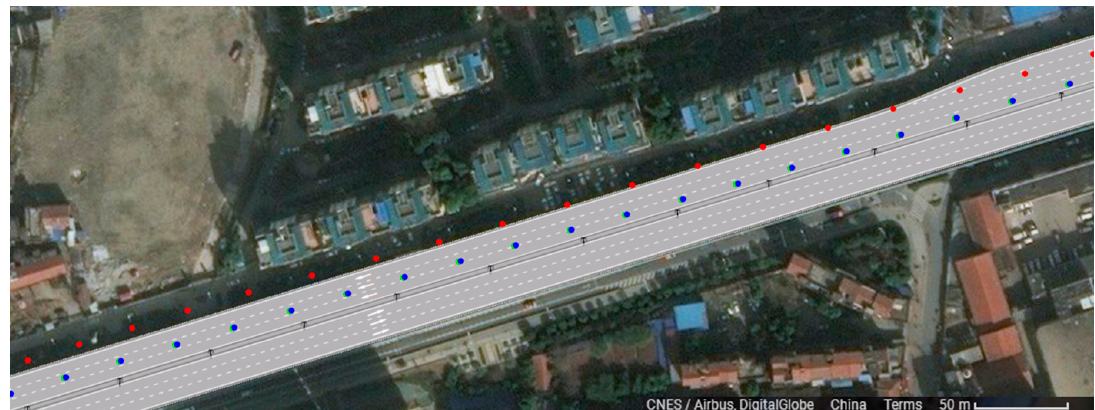
Figure 6. Demonstration of the vehicle trajectory on high precision map (the green one is obtained from high precision terminal; the red one is obtained from a Ublox UBX-M8030-KT; the blue one is obtained from the POS 620). Table 4. Accuracy assessment of the two methods.